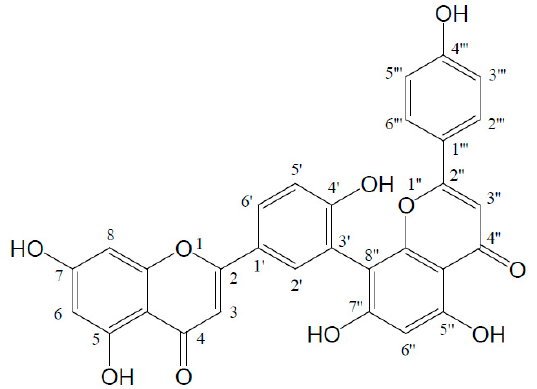
Figure 1. Chemical structure of amentoflavone.